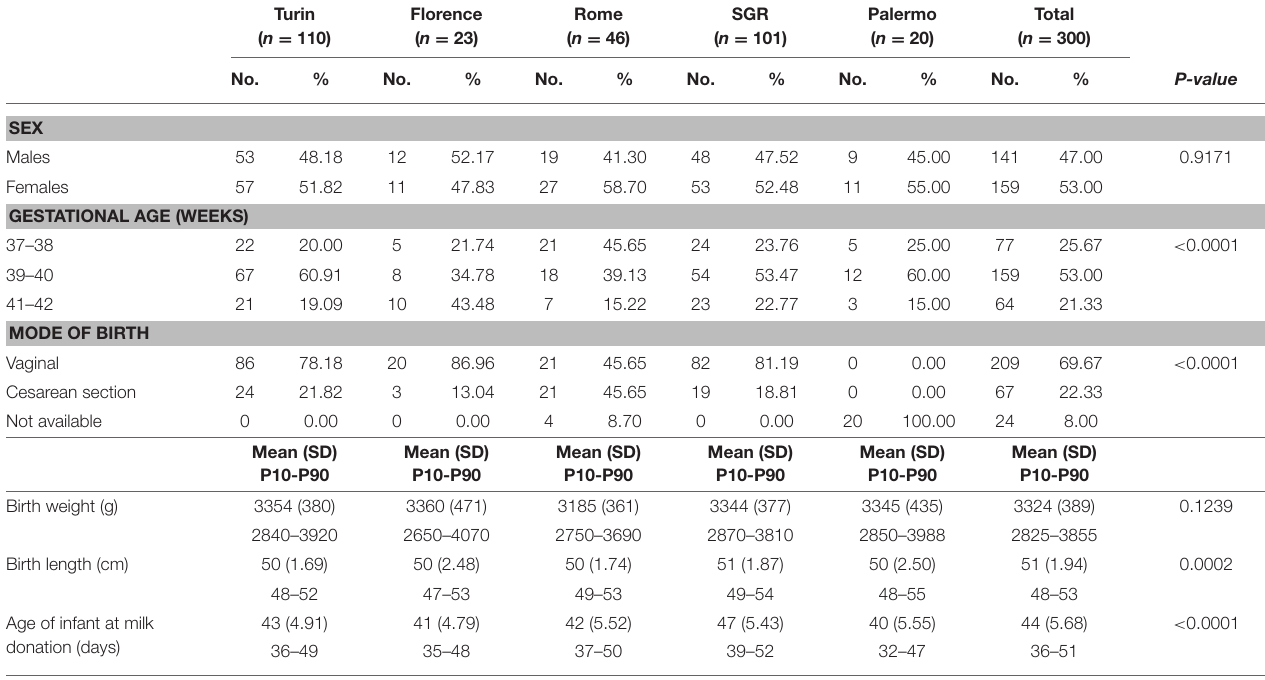
TABLE 3 | Infants characteristics by